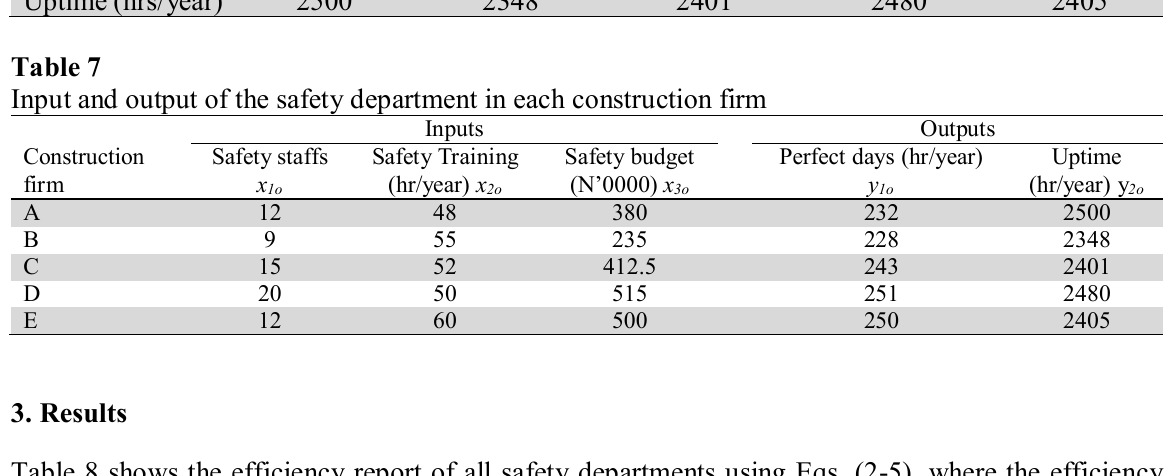
Uptime hours (hrs/year) Construction firm